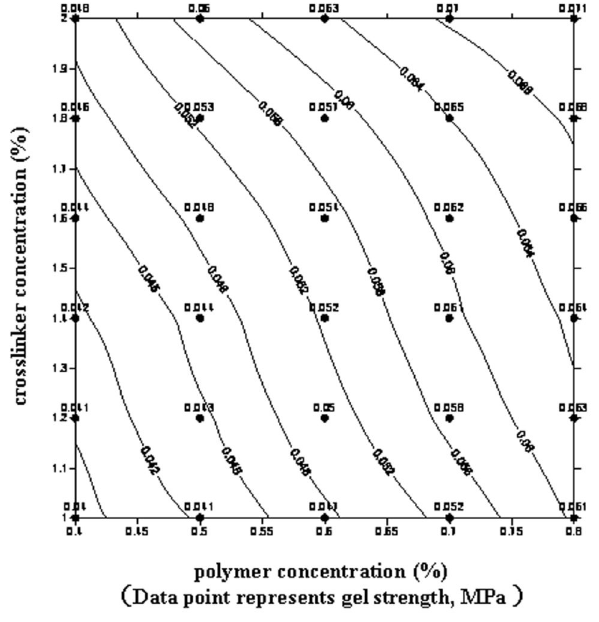
Figure 2. Contour map of gel